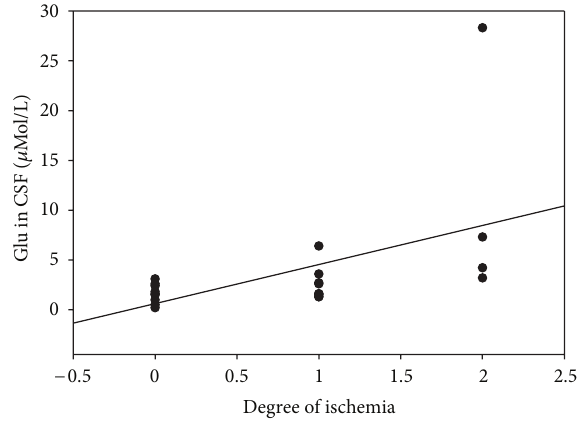
Figure 1: The graph depicts CSF Glu in association with the degree of